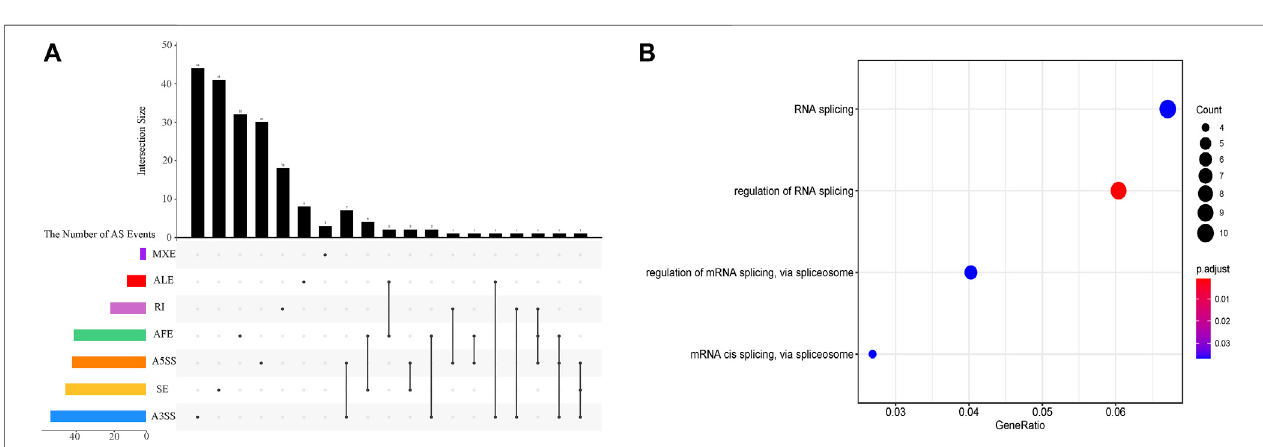
FIGURE 5 | The characterization of differential alternative splicing events between dome and 1k-cell. (A) Upset plot depicts the interactions among the seven patterns of alternative splicing events between dome and 1k-cell. (B) GO functional enrichment of differentially alternatively spliced genes between dome and 1k-cell.